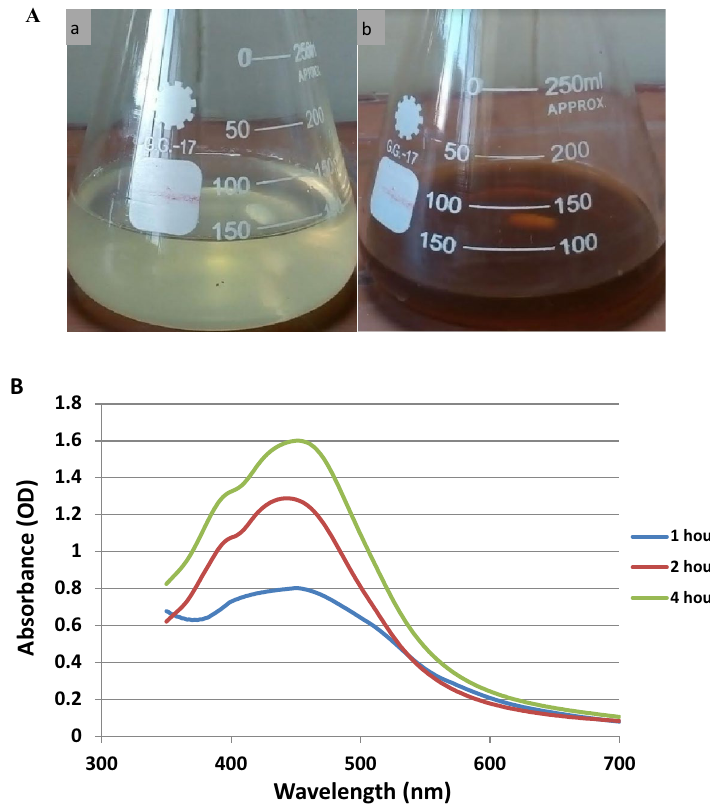
Figure 1. ( A ) aqueous solution of Oscillatoria limnetica (a) and biosynthesized Oscillatoria gelatin-capped AgNPs colloid (b) after an ahour of reaction, ( B ) Absorption spectra of the biosynthesized Oscillatoria gelatin- capped